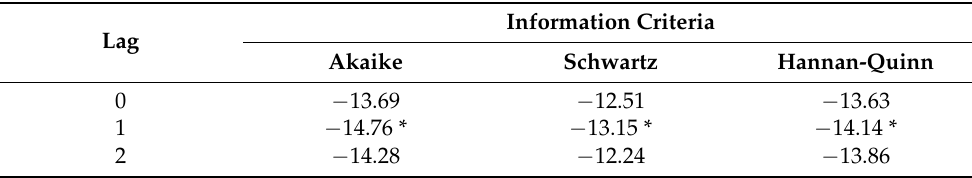
Table 4. Determining the optimal number of time lags for inclusion in the model for Ukraine in 2002–2019 (source: developed by the